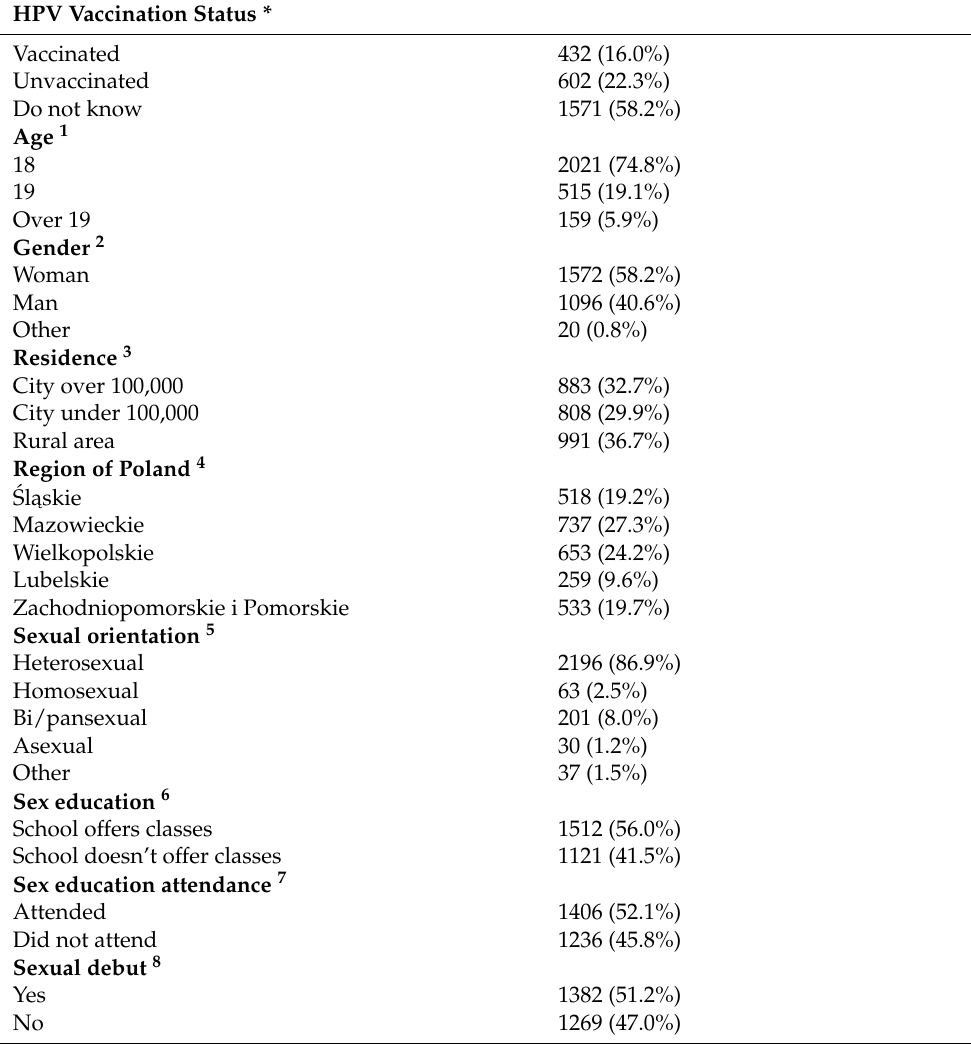
Table 1. General characteristics of the sample ( n = 2701)